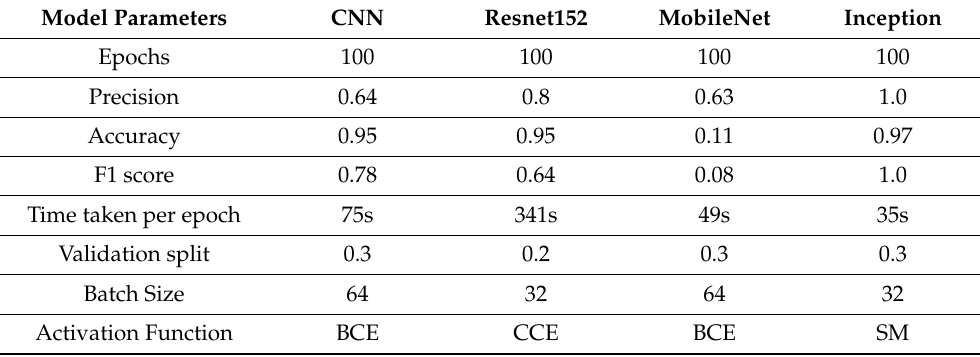
Table 4. Hyperparameters of chosen network architectures with results. Model